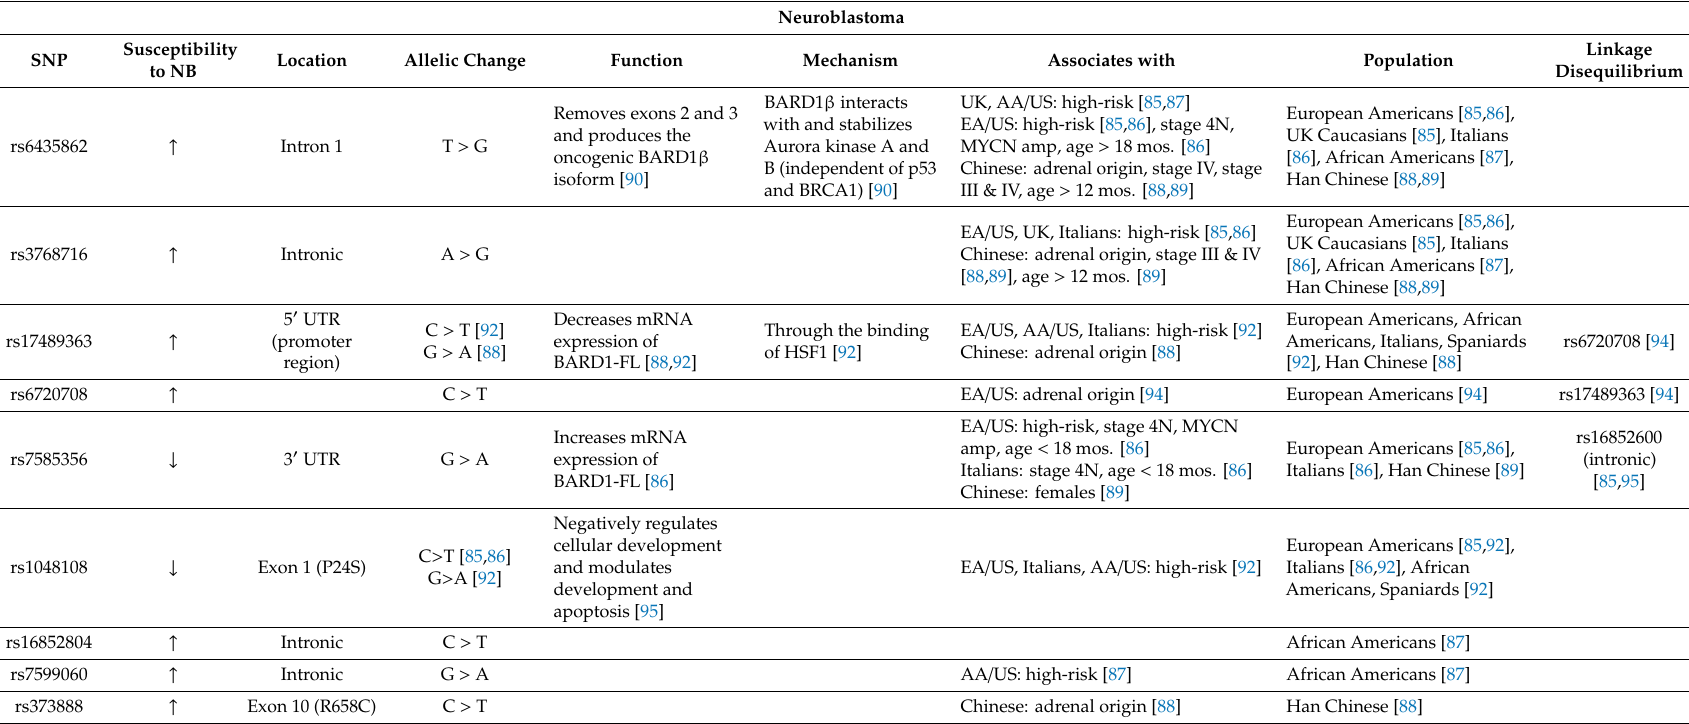
Table 1. Common single nucleotide polymorphisms (SNPs) of the BARD1 gene identified in